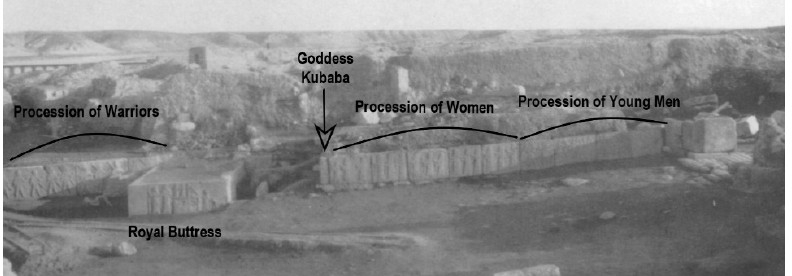
Figure 4. The Royal Buttress and the adjoining older relief cycles (photo reproduced from Ussishkin 1967, pl.